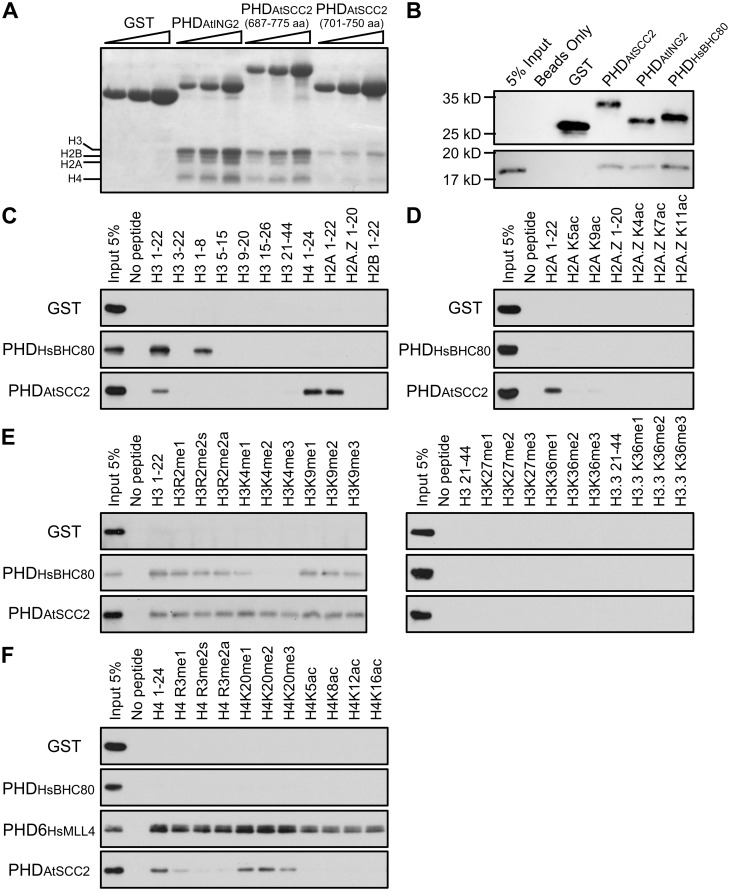
AtSCC2 PHD can bind to histones.(A) Pull-down assay of GST, GST-AtING2PHD, GST-AtSCC2PHD (687–775 aa), GST-AtSCC2PHD (701–750 aa) with calf thymus histones. (B) Pull-down assay of GST, GST-HsBHC80PHD, GST-AtSCC2PHD (687–775 aa) with H3. (C) Pull-down assay of GST, GST-HsBHC80PHD, GST-AtSCC2PHD (687–775 aa) with different histone peptides in N terminal length. (D) Pull-down assay of GST, GST-HsBHC80PHD, GST-AtSCC2PHD (687–775 aa) with unmodified and modified H2A peptides. (E) Pull-down assay of GST, GST-HsBHC80PHD, GST-AtSCC2PHD (687–775 aa) with unmodified and modified H3 peptides. (F) Pull-down assay of GST, GST-HsBHC80PHD, GST-AtSCC2PHD (687–775 aa) with unmodified and modified H4 peptides.